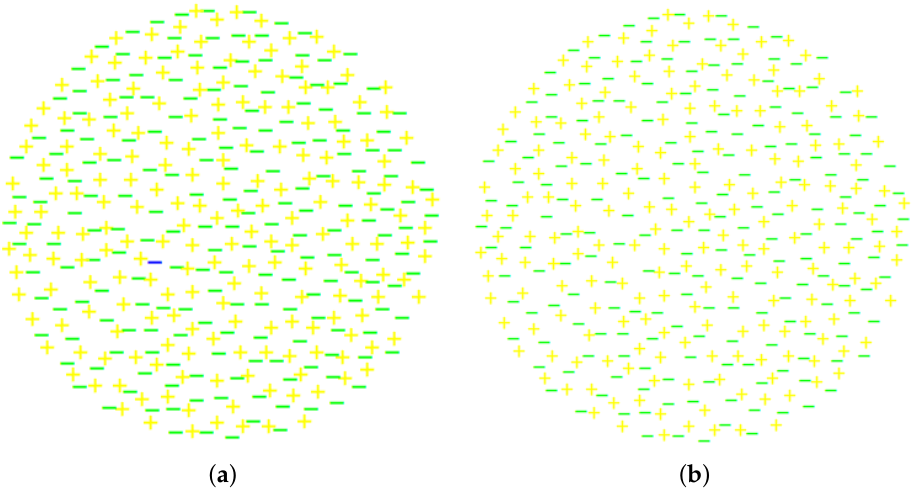
Figure 1. Collections ( a , b ) have 201 and 200 electrons, respectively, and 200 positrons